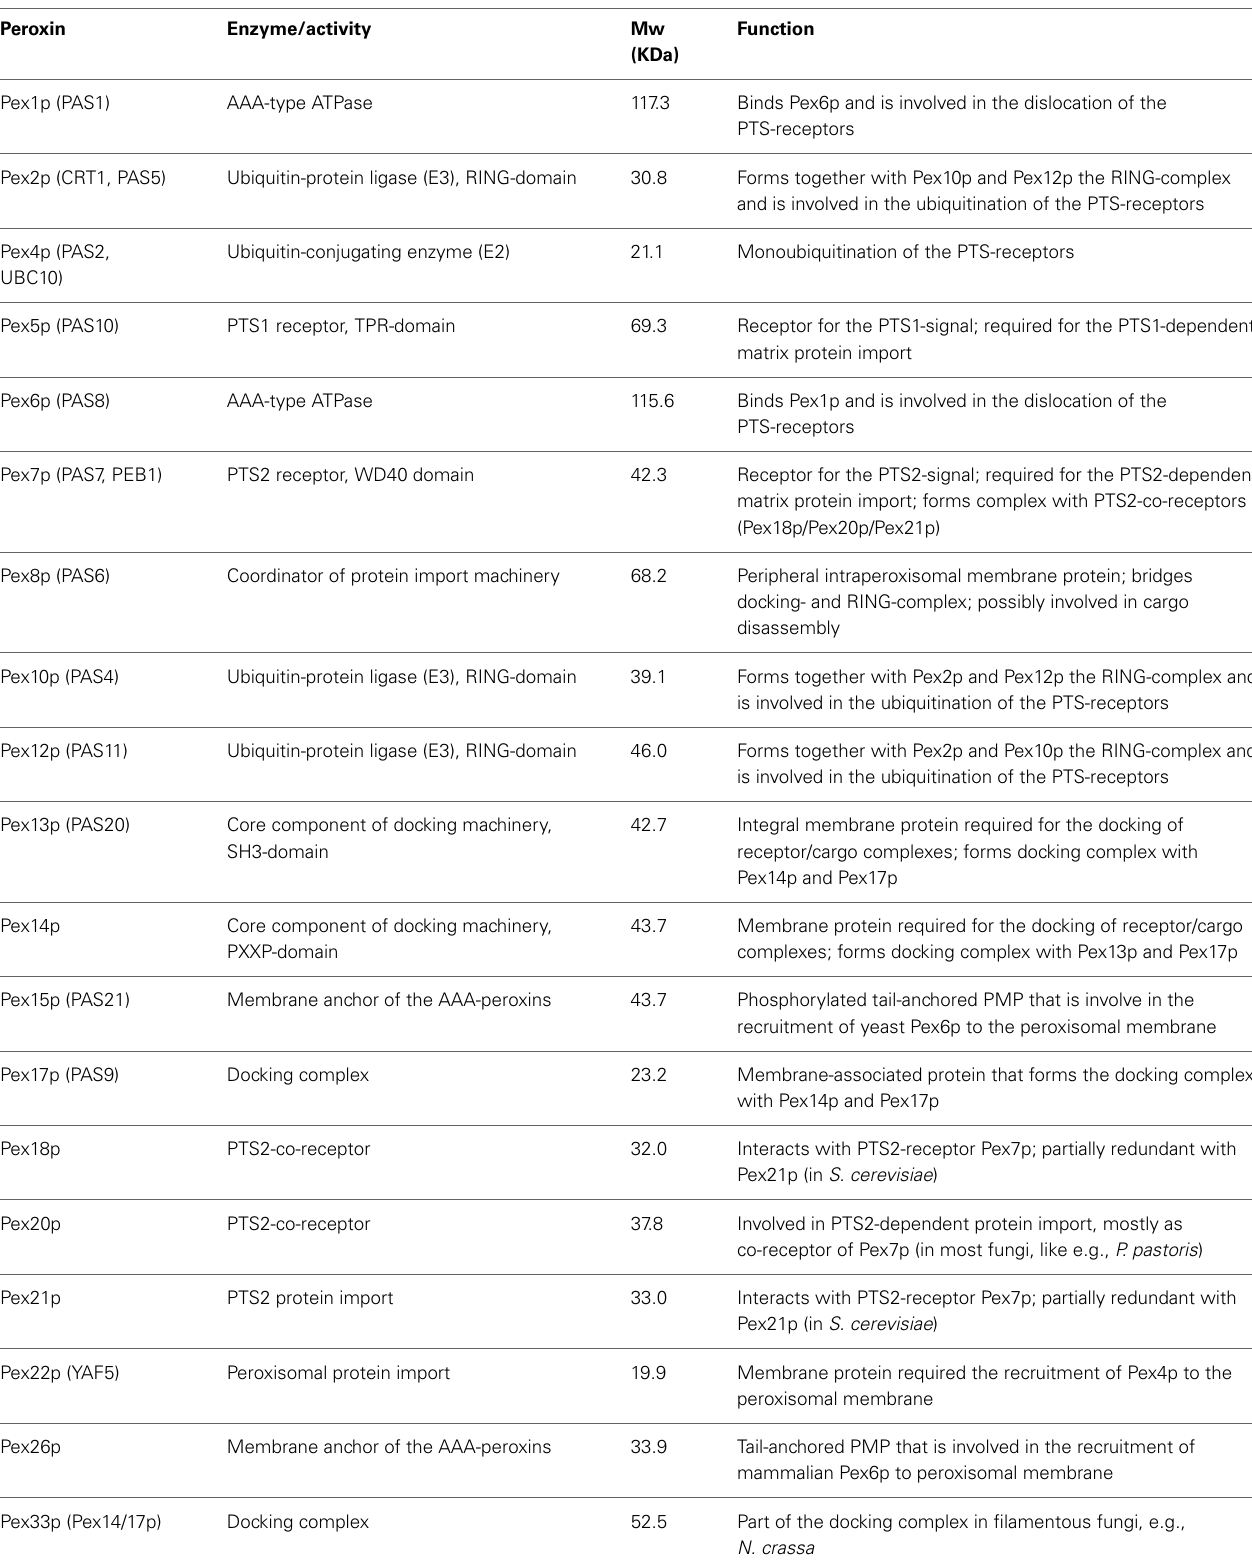
Table 1 | Peroxins involved in peroxisomal matrix protein